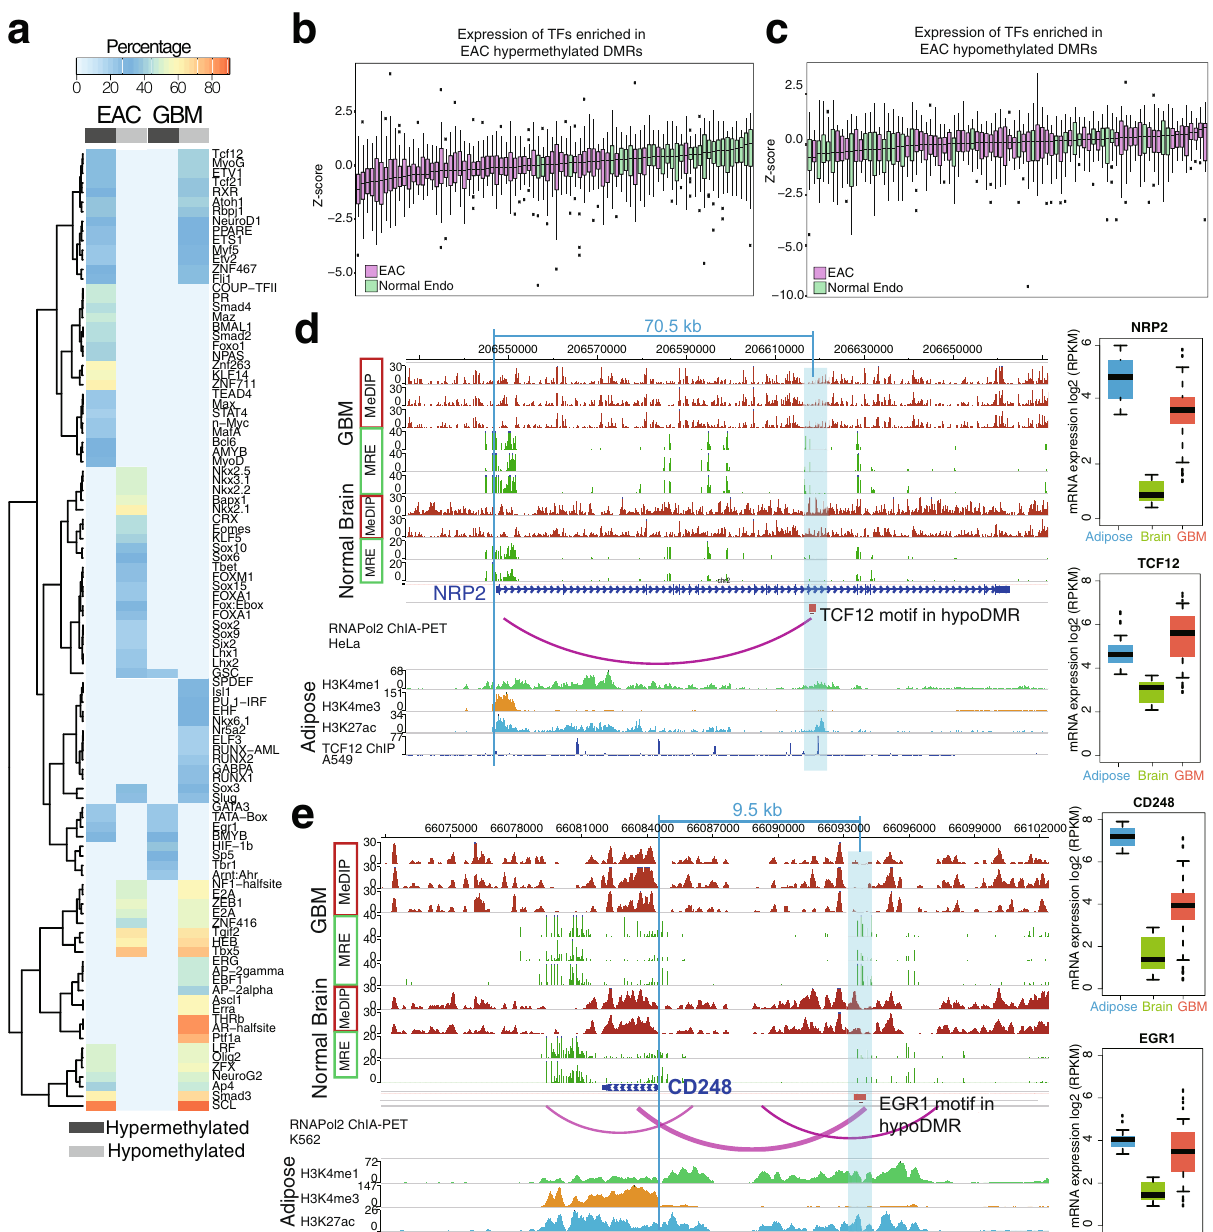
Fig. 3 Abnormally methylated enhancer-potential regions in cancer are associated with deregulated transcription factors. a Percentage of EAC and GBM DMRs with enriched transcription factor-binding motifs. Only those with a q -value ≤ 0.01 and percentage ≥ 20% are shown. b , c Normalized expression (RPKM, z -scores) of TFs enriched in EAC ce-hyperDMRs ( b , number of EAC samples = 57, number of normal endometrial samples = 29, number of TFs = 30) and ce-hypoDMRs ( c , number of EAC samples = 57, number of normal endometrial samples = 29, number of TFs = 21) in normal endometrium (green) and EAC (purple) samples. d Epigenome Browser 74,75 view demonstrating a hypoDMR (blue highlighted region) across GBM samples within the NRP2 gene. The DMR contains a TCF12-binding motif, as evidenced by a ChIP-seq peak for the TF in A549 cells, which